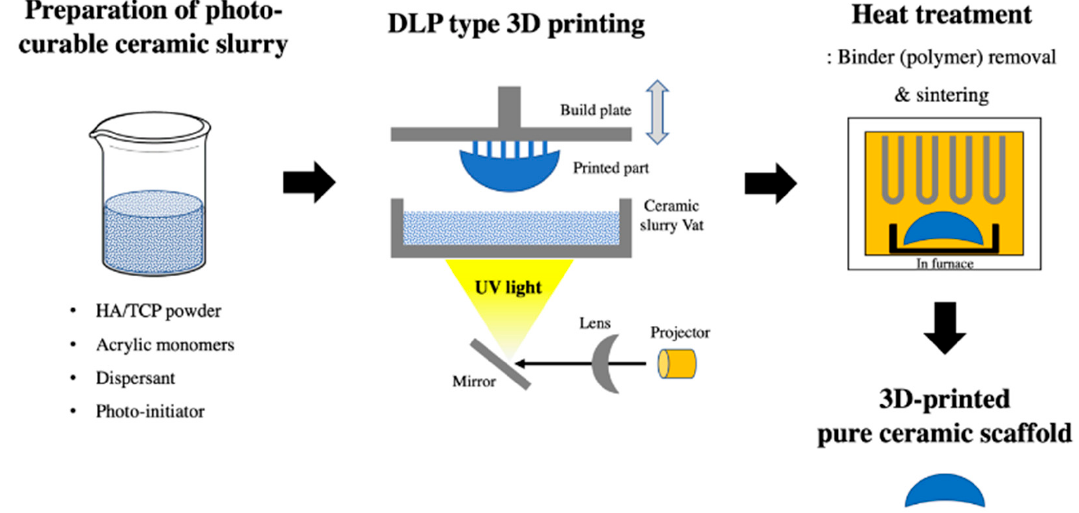
Figure 3. Digital light processing (DLP) 3D-printing process of the pure hydroxyapatite (HA)/tricalcium phosphate (TCP) scaffold.